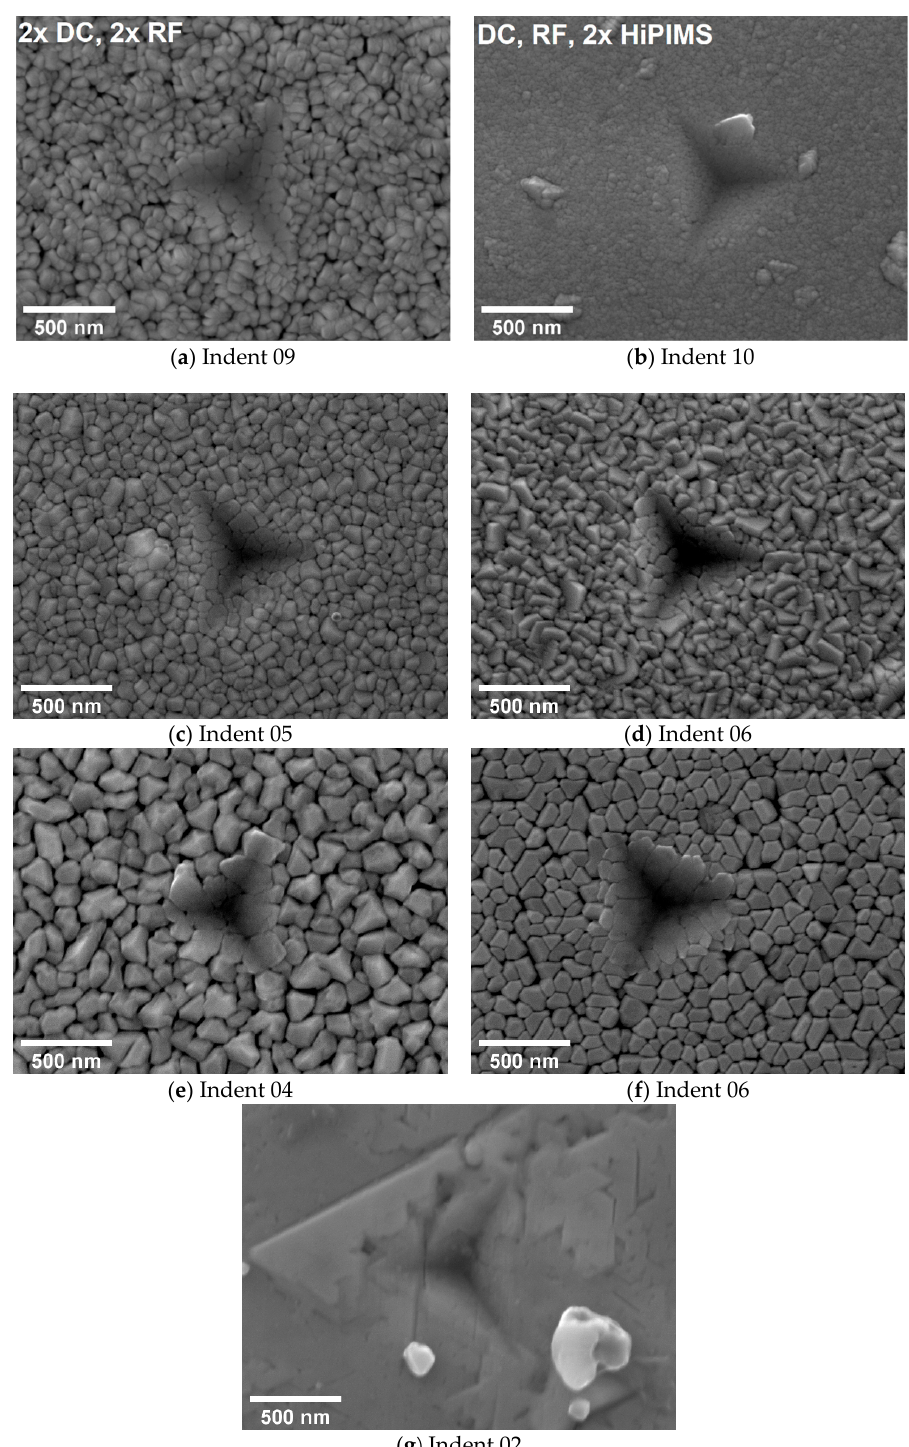
two HiPIMS generators.